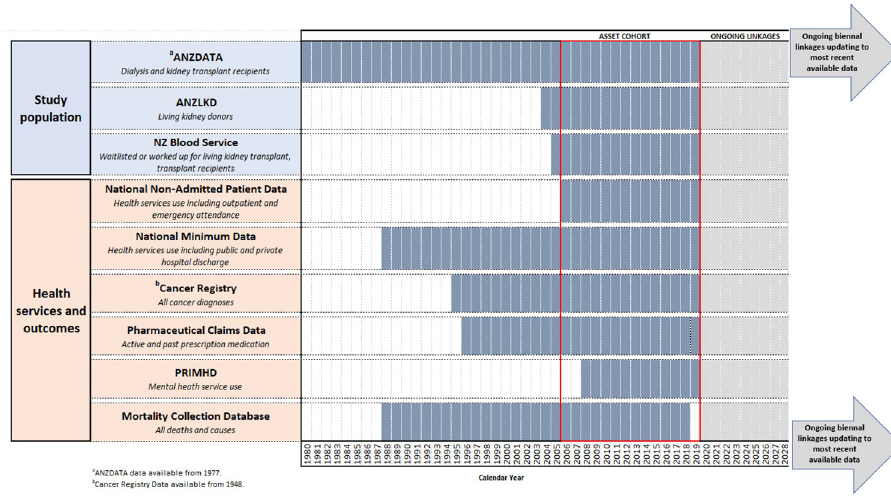
Fig 2. Calendar years of available data from each data source included in the initial data linkage to create ASSET data platform. Study population databases include ANZDATA (Australia and New Zealand Dialysis and Transplant Registry), ANZLKD (Australia and New Zealand Living Kidney Donor Registry) and NZ Blood Service (New Zealand Blood Service Database). Health outcomes databases include National Non-Admitted Patient Data, National Minimum Data, Cancer Registry, Pharmaceutical Claims Data, PRIMHD (Programme for the Integration of Mental Health Data) and Mortality Collection Database. ASSET data platform will be relinked biennially to include most recent available data and any additional databases for ongoing health services